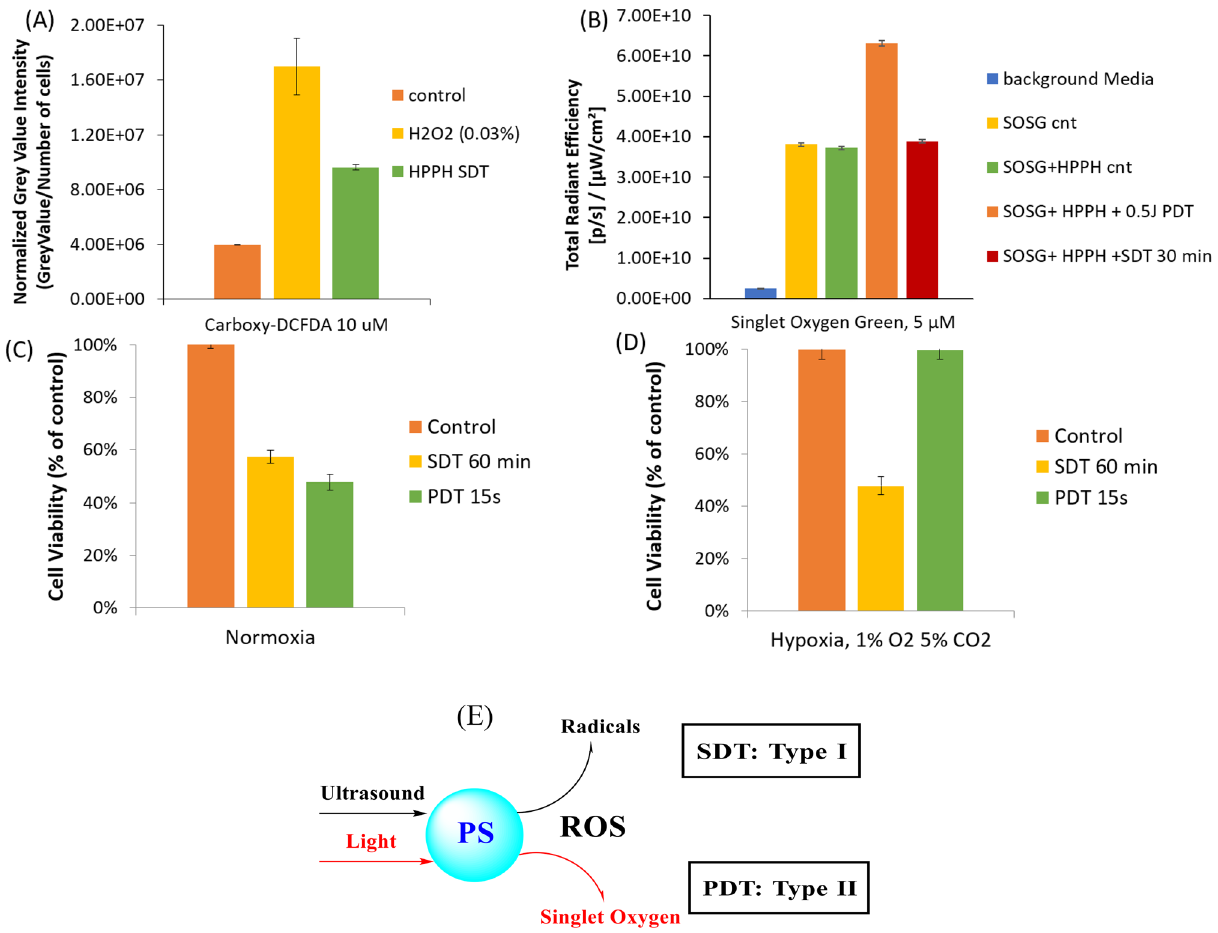
Figure 4. U87 cells incubated with 1 µM of HPPH formulated in either Tween or cationic PAA-NMe 3+ and the number of cells was counted utilizing a trypan blue assay. To understand the type of ROS (singlet oxygen or radical ions) responsible of cell-kill mechanism the cells were incubated with carboxy-DCFDA and exposed to US or H 2 O 2 (positive control for radical ions) ( A ) in vitro ROS measurement by Carboxy-DCFDA. Cells were imaged with fluorescent microscope and analyzed using ImageJ Grey Value intensity of the photosensitizer then normalized to number of cells. For detection of single oxygen, SOSG (a singlet oxygen quencher) was added to a test tube along with 10 µM of HPPH and exposed to light or US. The resulting fluorescence of SOSG